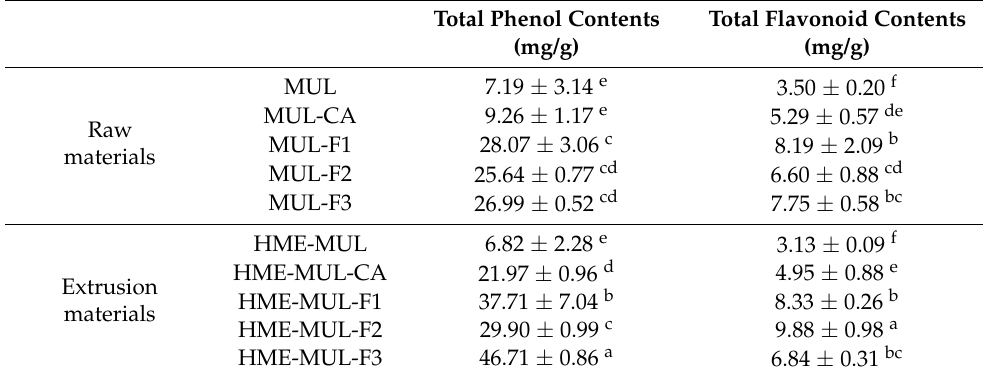
Table 2. Total phenol contents, total flavonoid contents, and total ACN contents in MUL